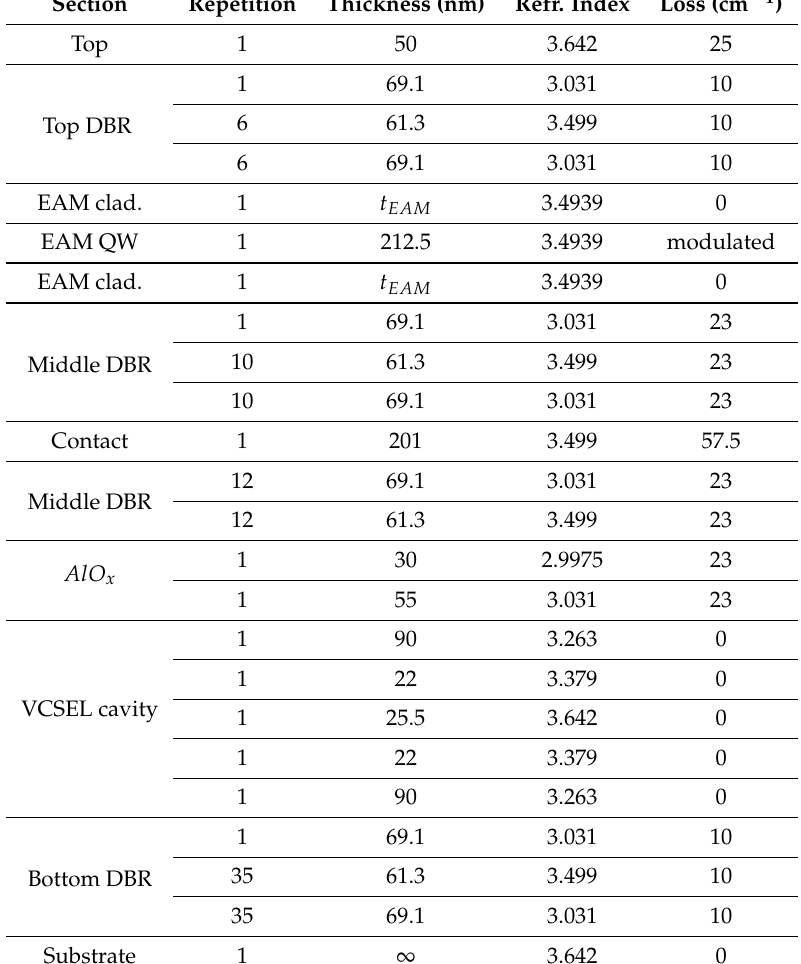
Table 1. Electro-absorption modulator vertical-cavity surface-emitting laser (EAM-VCSEL) structure. Section Repetition Thickness (nm) Refr. Index Loss (cm − 1 )